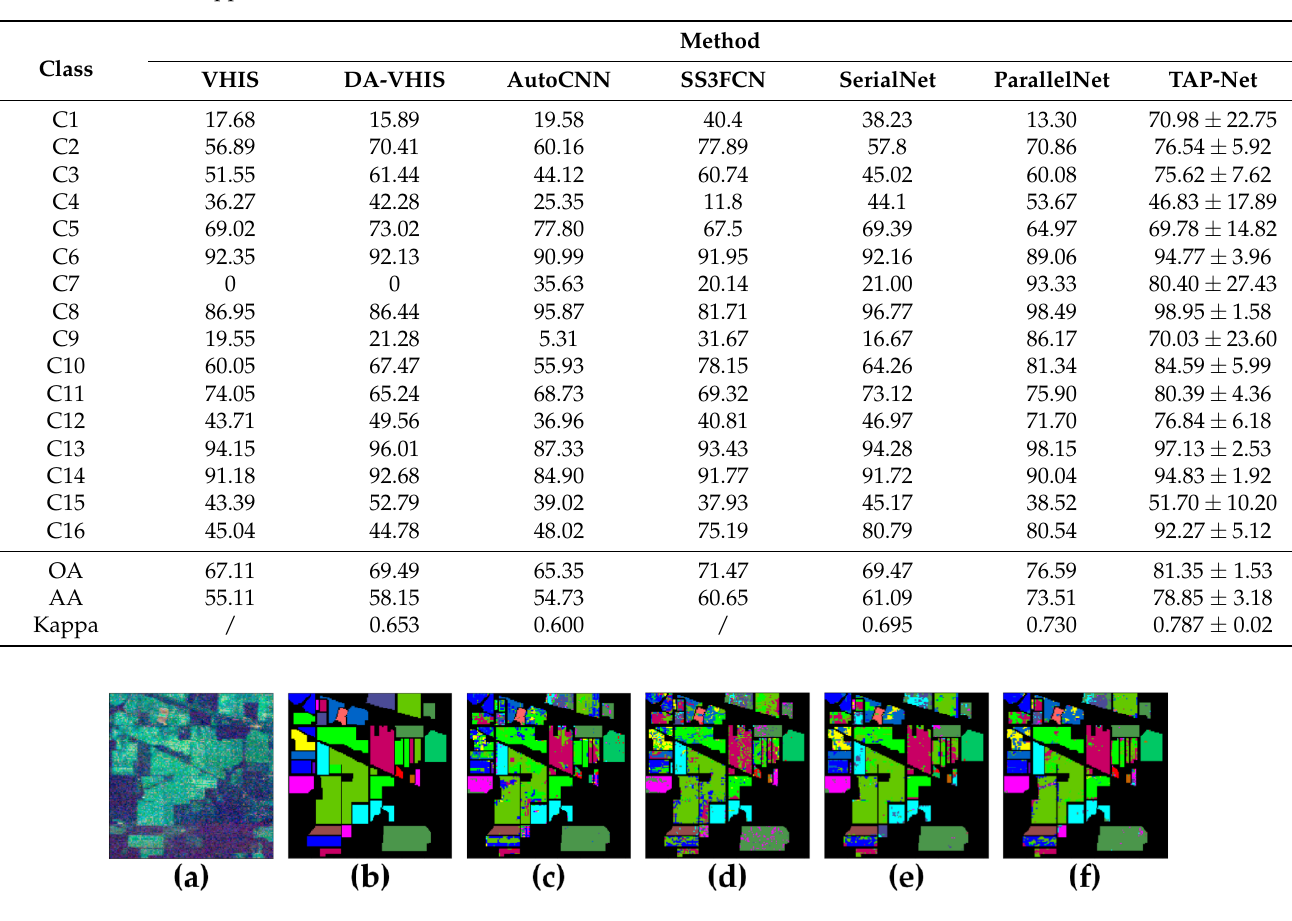
Table 7. Classification results for the Indian Pines dataset, including per-class, overall (OA), and average (AA) accuracy (in %), and the Kappa scores.